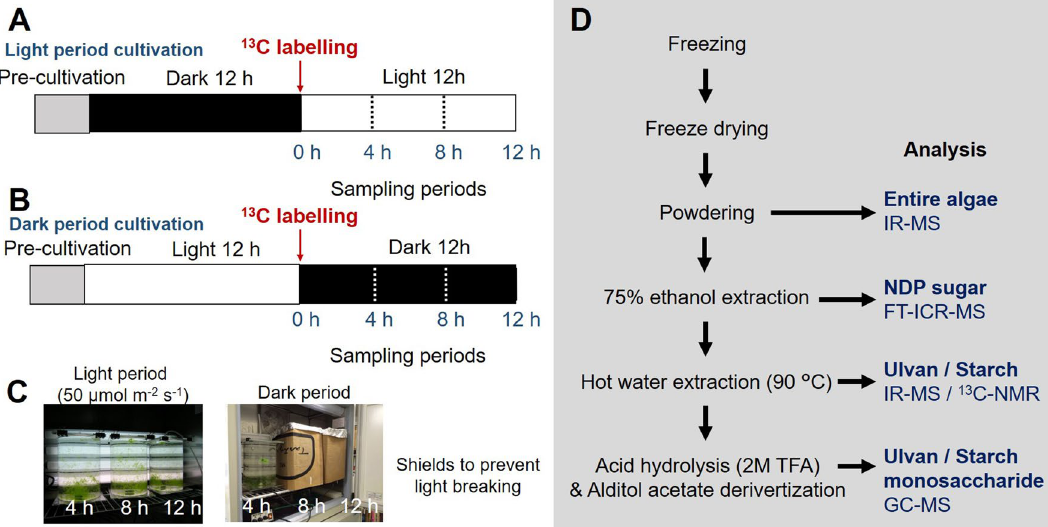
Figure 6. The 13 C labelling and sampling periods of Ulva meridionalis under ( A ) light and ( B ) dark. ( C ) The photographs of each cultivation tank for sampling U. meridionalis after 4–12 h. ( D ) Fractionations and analyses of nucleic diphosphate sugar, ulvan / starch, and ulvan / starch